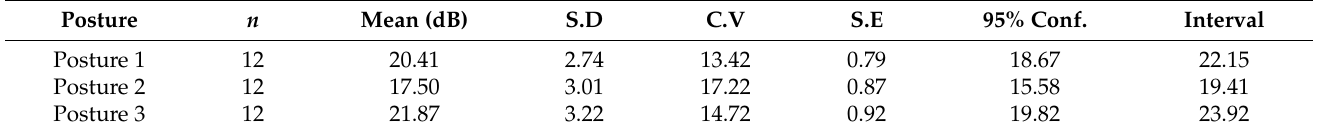
Table 3. TTS (125 Hz) test results statistics.